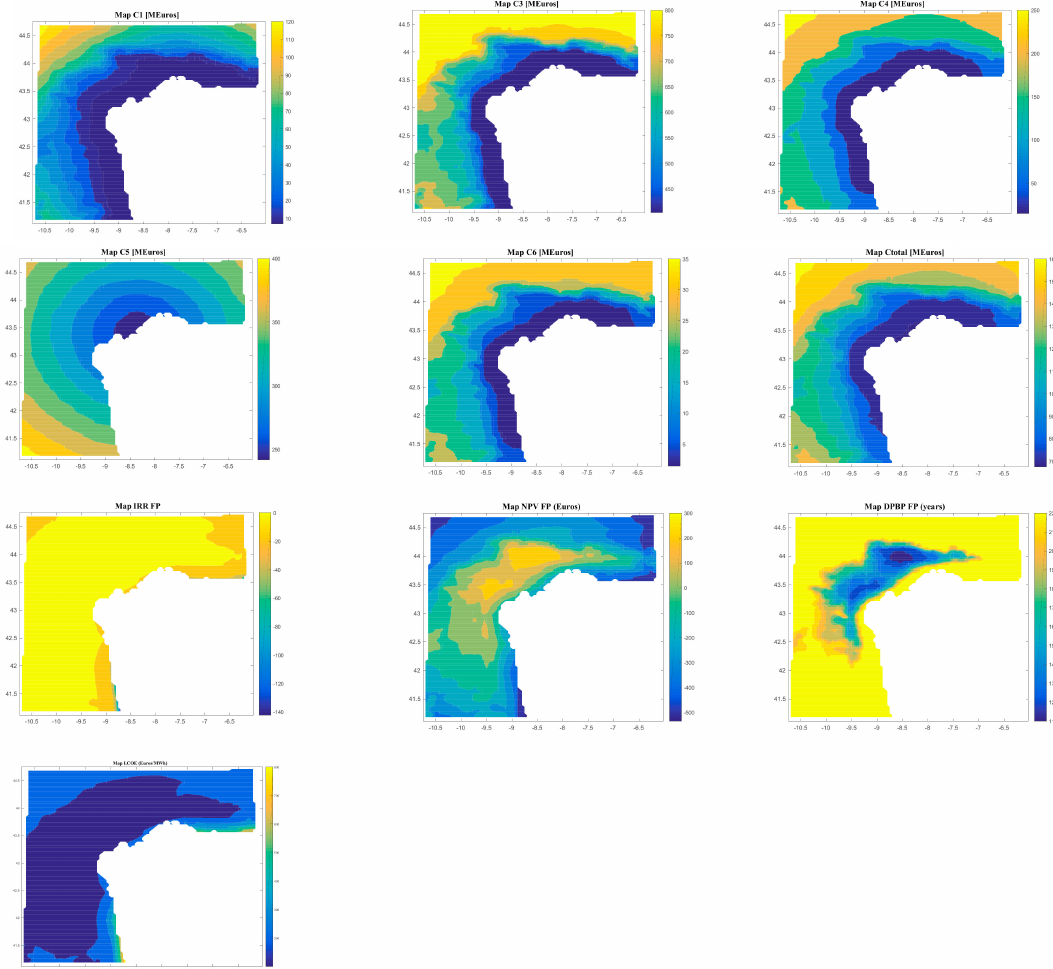
Figure 8. Results (C1, C1, C3, C4, C5, C6, Ctotal, LCOE, DPBP, IRR, NPV) for Case